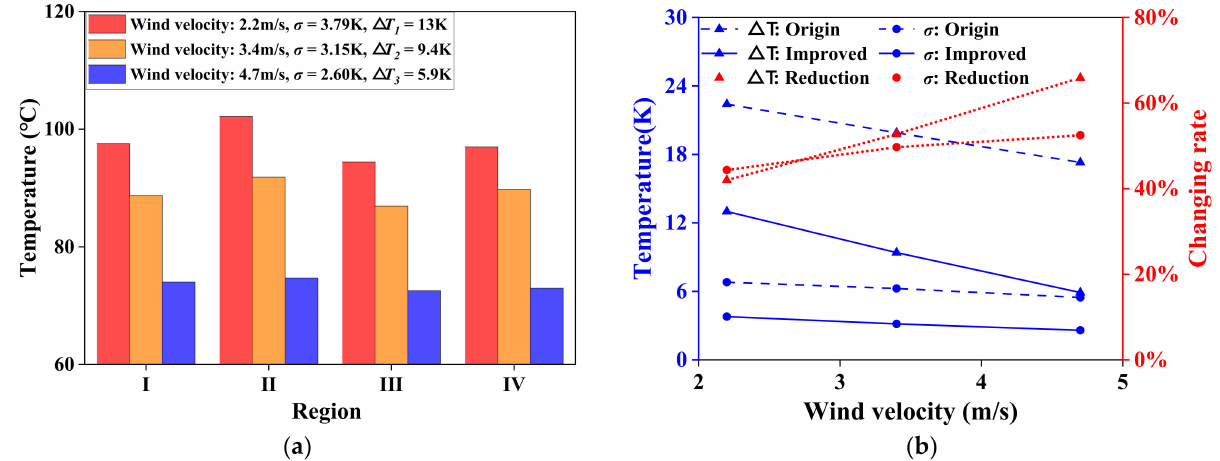
Figure 19. Wind velocity effect on temperature distribution. ( a ) Winding temperature distribution for the improved specimen under a current density of 20.6 A/mm 2 and different wind velocities (2.2 m/s, 3.4 m/s and 4.7 m/s). ( b ) Comparison of (cid:52) T and σ between the original and improved specimens under different wind